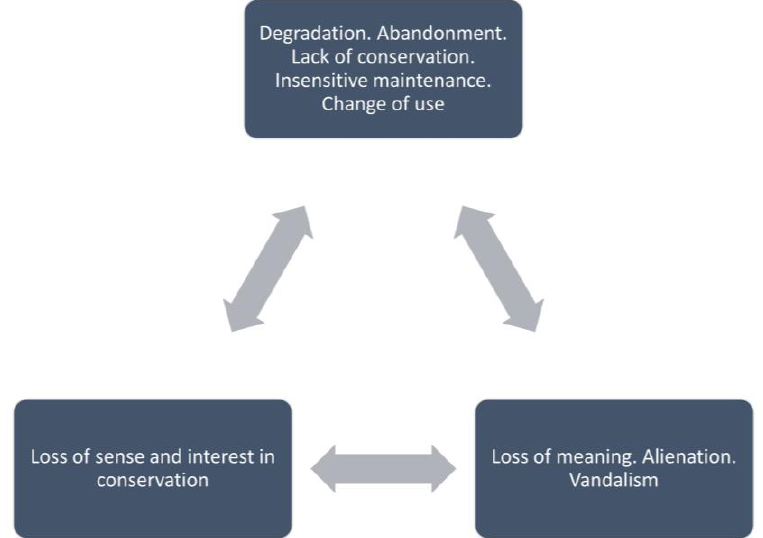
Figure 15. Heritage conservation cycle. Own elaboration.